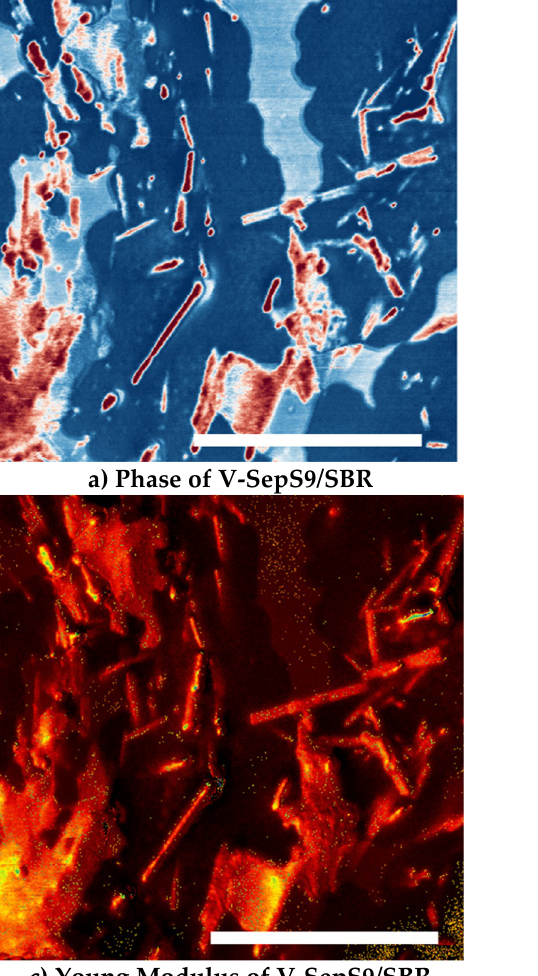
Figure 10. Intermodulation Atomic Force Microscopy (AFM) phase images of ( a ) V-SepS9/SBR, ( b ) V-NS-SilSepS9/SBR. Young modulus calculated from the DMT model and the intermodulation product amplitude and phase images of ( c ) V-SepS9/SBR, ( d ) V-NS-SilSepS9/SBR. The white scale bar is 1.0 μm. The phase scale is 25 degrees, and the Young modulus scale is 2.0 GPa.